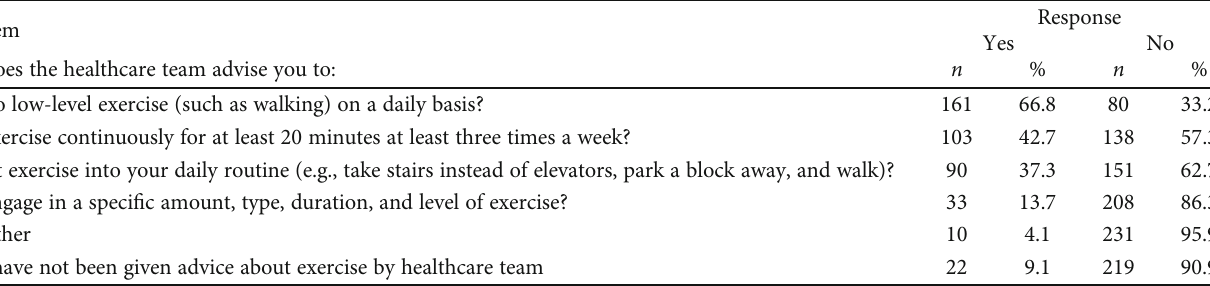
Table 4: Responses to the extended SDSCA survey exercise domain.